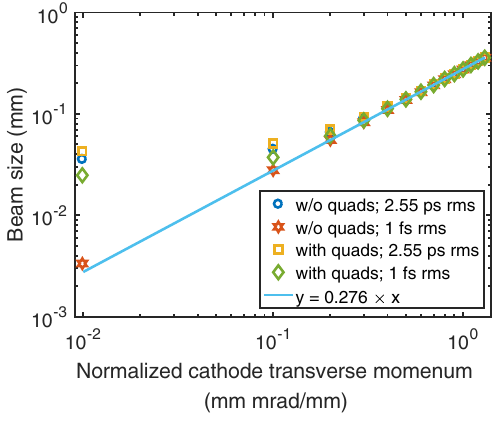
FIG. 5. The beam size at the observation screen versus the normalized cathode transverse momentum at MMMG phase. The data points are the simulation results. The blue circles and red hexagrams assume an ideal solenoid without quadrupole field errors and the bunch lengths are 2.55 ps rms and 1 fs rms, respectively. The yellow squares and green diamonds include the quadrupole field errors of the solenoid. The line is the linear